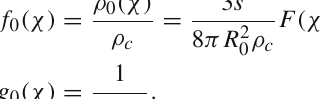
motions fall into the black hole. However, V (χ) approaches a constant value as χ → −∞ .